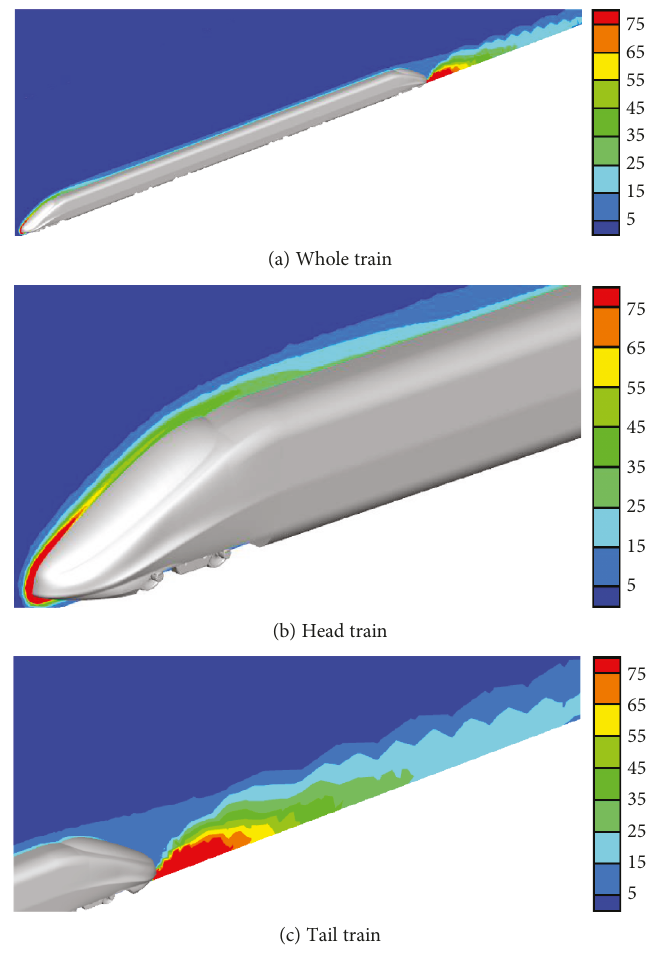
Figure 9: Distribution of turbulence kinetic energy around high-speed